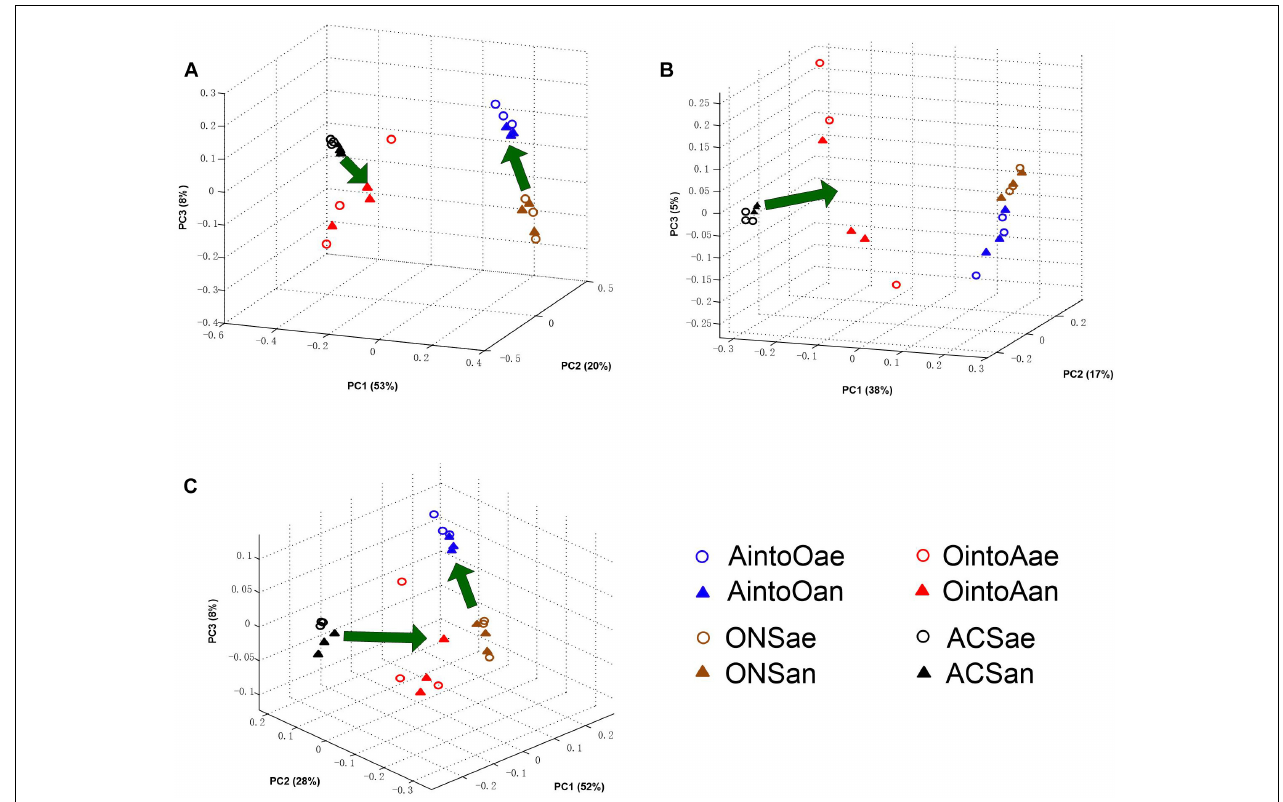
FIGURE 2 | Community coalescence of the soil bacterial communities after reciprocal inoculation. (A) Bray-Curtis PCoA of the soil bacterial community structure based on the OTU data. (B) Unweighted UniFrac PCoA of the soil bacterial community structure based on the OTU data. The percentage of the variation explained by the plotted PCs is shown in parentheses. (C) Weighted UniFrac PCoA of the soil bacterial community structure based on the OTU data. The percentage of the variation explained by the plotted PCs is shown in parentheses. The percentage of the variation explained by the plotted principal coordinates (PCs) is shown in